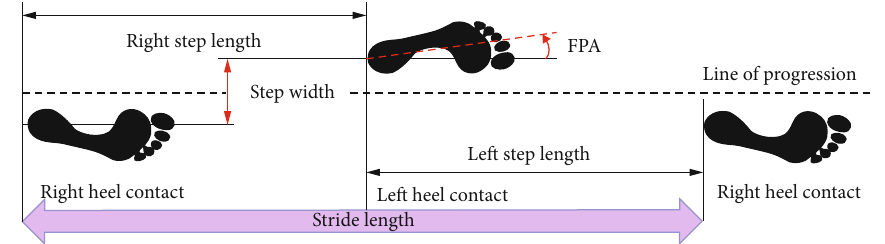
Figure 4: Spatial description of gait. FPA: foot progression